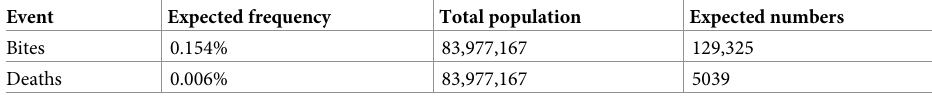
Table 2. Estimated snakebite cases and deaths for a period of 1